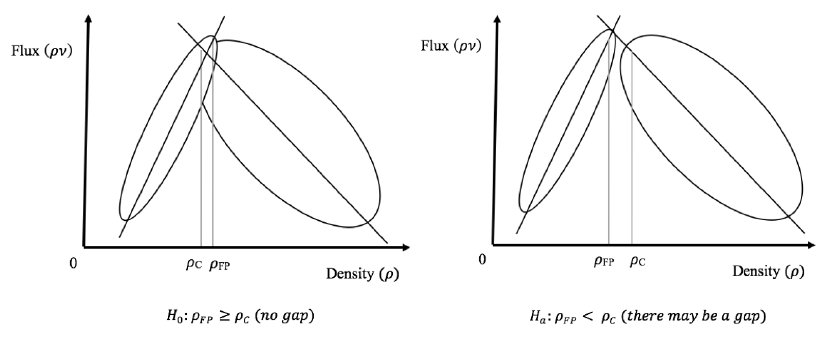
Figure 2. Illustration of hypothesis testing procedure for phase